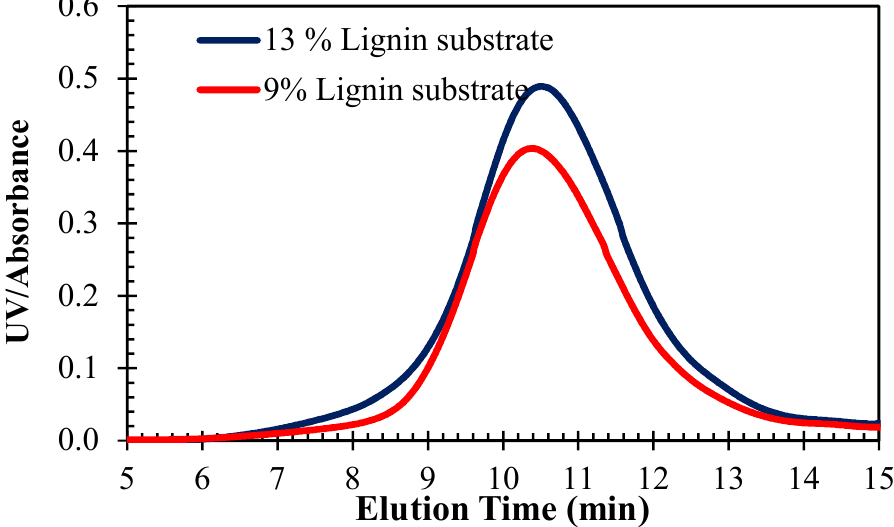
Figure 4. Effect of the initial KL concentration on M w of DKLs from treatment of black liquor with two different initial lignin concentrations (13 wt. % and 9 wt. %), K7 and H1, at 250 ◦ C for 2 h.